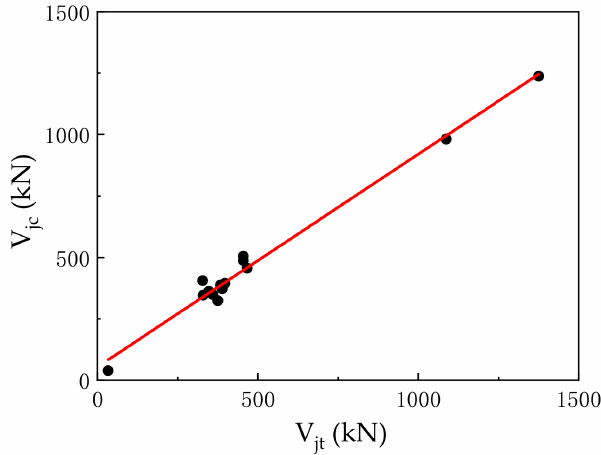
Figure 19. Regression analysis